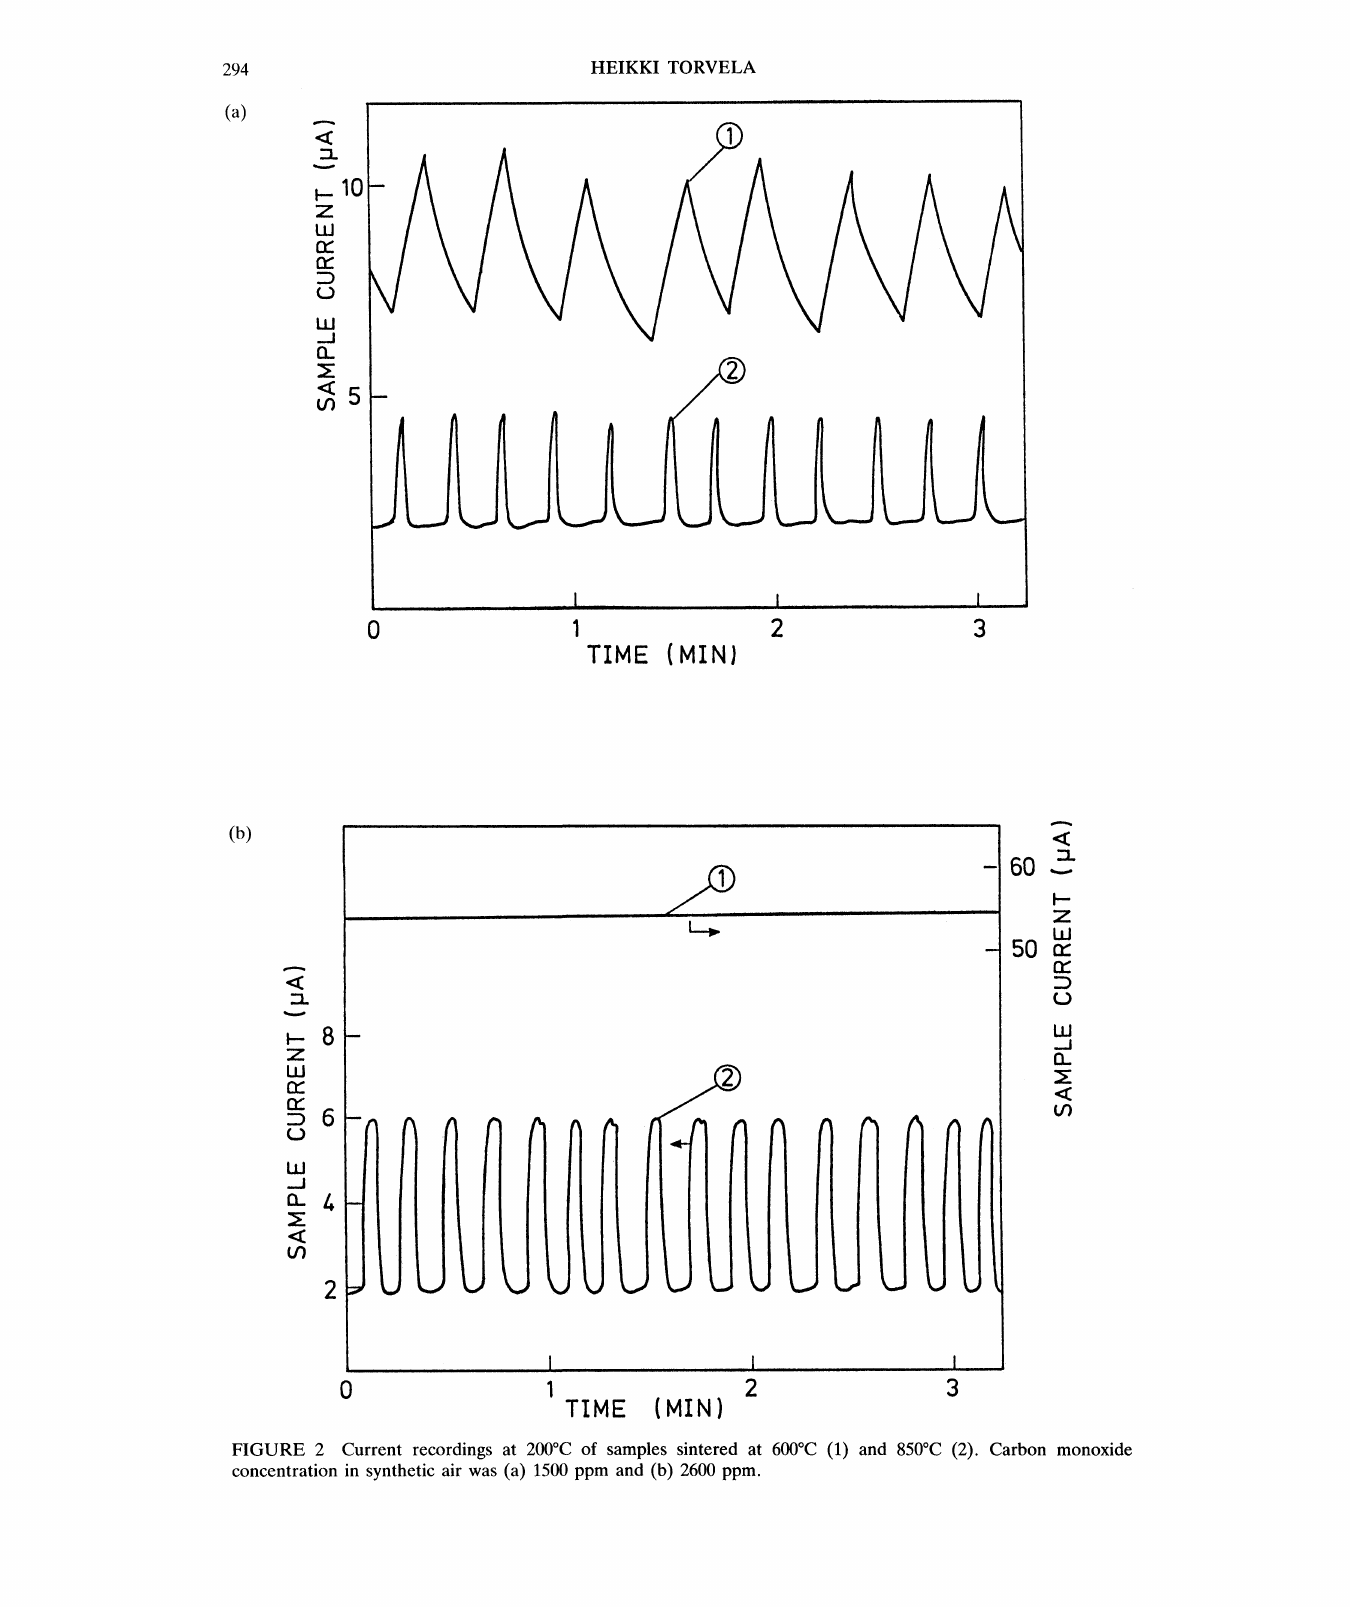
FIGURE 2 Current recordings at 200C of samples sintered at 600C (1) and 850C (2). Carbon monoxide concentration in synthetic air was (a) 1500 ppm and (b) 2600